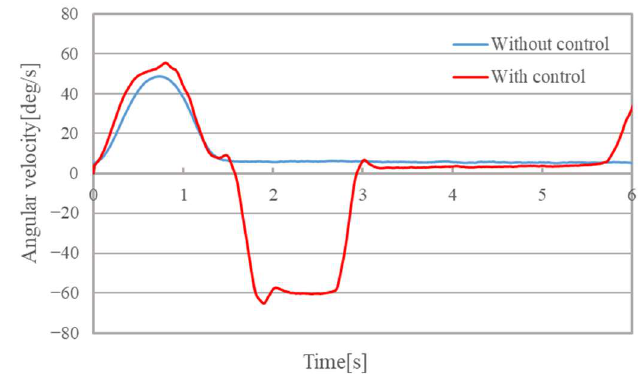
Figure 11. Time history of angular velocity (experimental results). Next, the effect of control is examined based on the numerical simulation